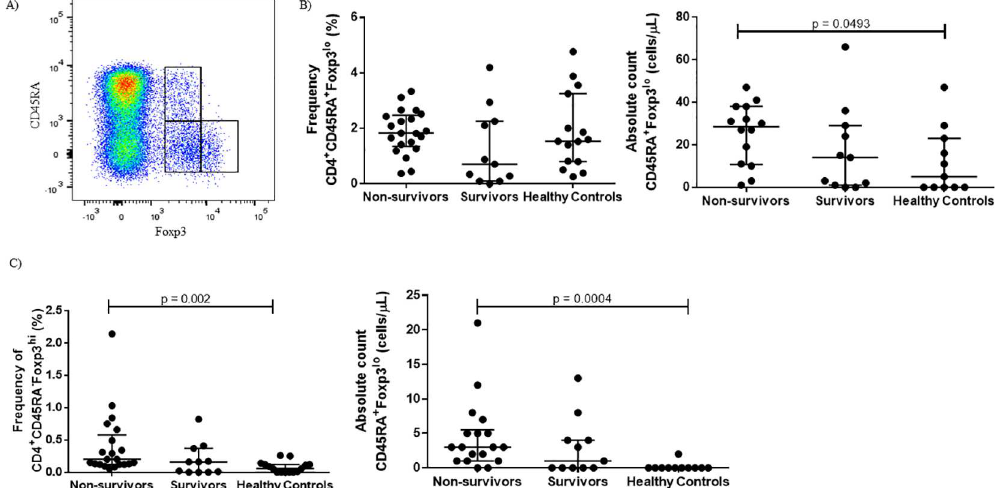
Fig 2. Higher numbers of both CD45RA + Foxp3 lo na ï veTreg (nTreg cells) and CD45RA - Foxp3 hi effector Treg (eTreg) cells are associated with poor outcome. (A) Gating strategy differentiatingnTreg and eTreg cells from CD45RA - Foxp3 lo non-Tregcells. At the time of diagnosis, eBL non-survivors have higherabsolutecell counts of both nTreg (B) and eTreg (C) cell subtypes comparedto eBL survivors and